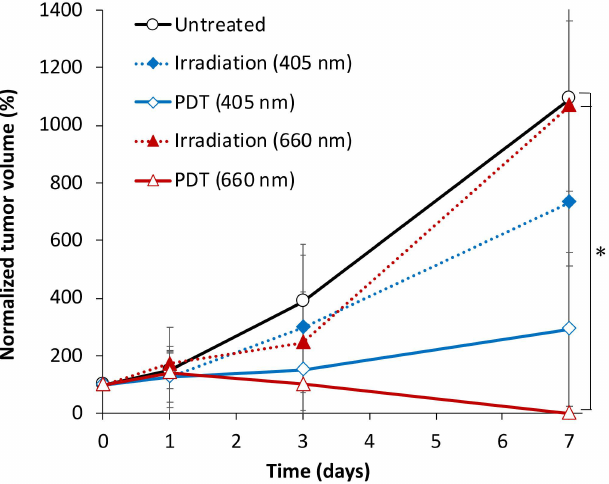
Figure 3. CT26 tumor volume dynamics after red- and blue-light PDT with Photolon and red- and blue-light irradiation only treatment. The data presented as M ± SD, asterisk (*) shows statistically significant difference between the treatment groups ( p < 0.05, one-way ANOVA with Duncan test).